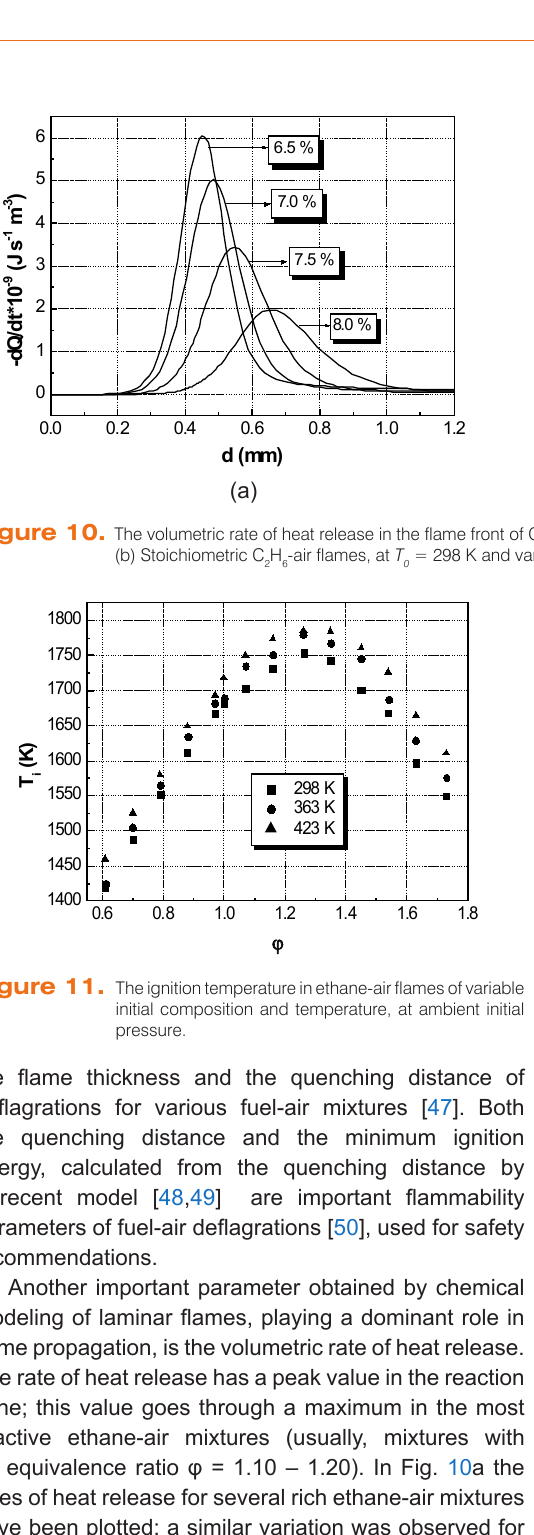
Figure 10. The volumetric rate of heat release in the flame front of C